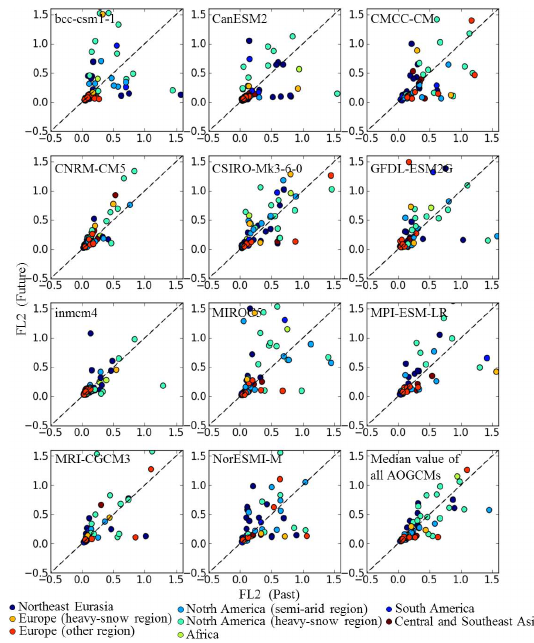
Fig. A4. Comparisons of the coefficient of variation in the Julian date of annual minimum flow (TL2) between past and future in each of the 11 coupled atmosphere–ocean general circulation